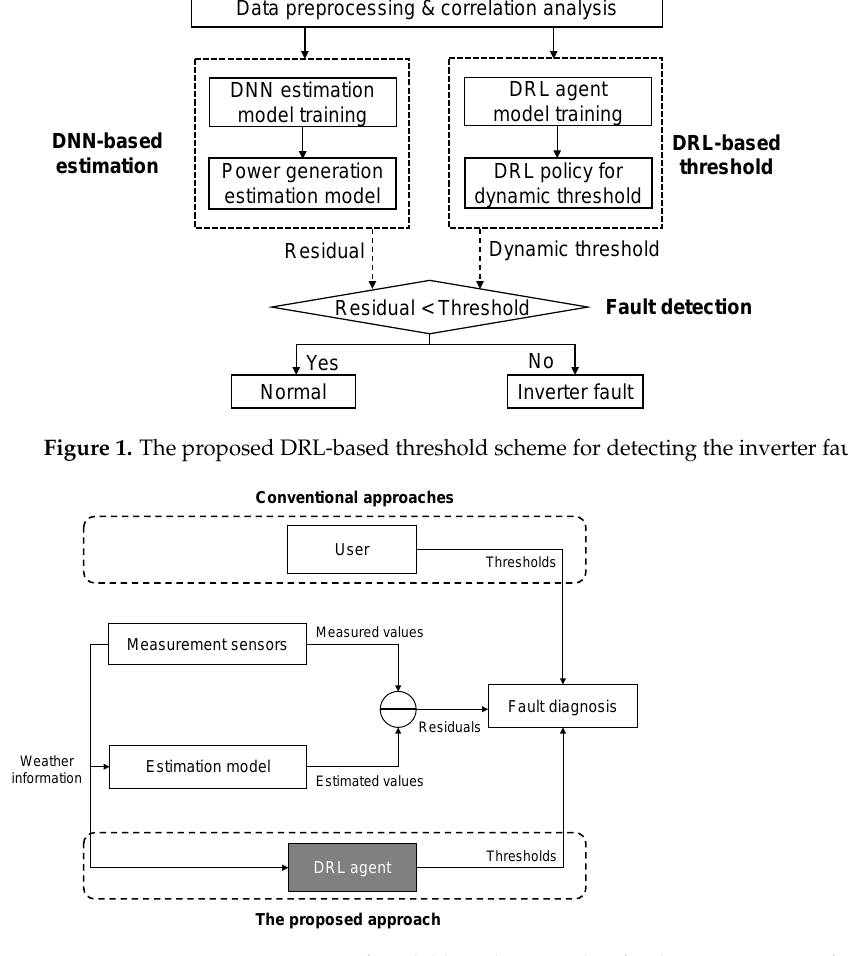
Figure 2. Structure comparison of model-based approaches for detecting inverter faults of PV